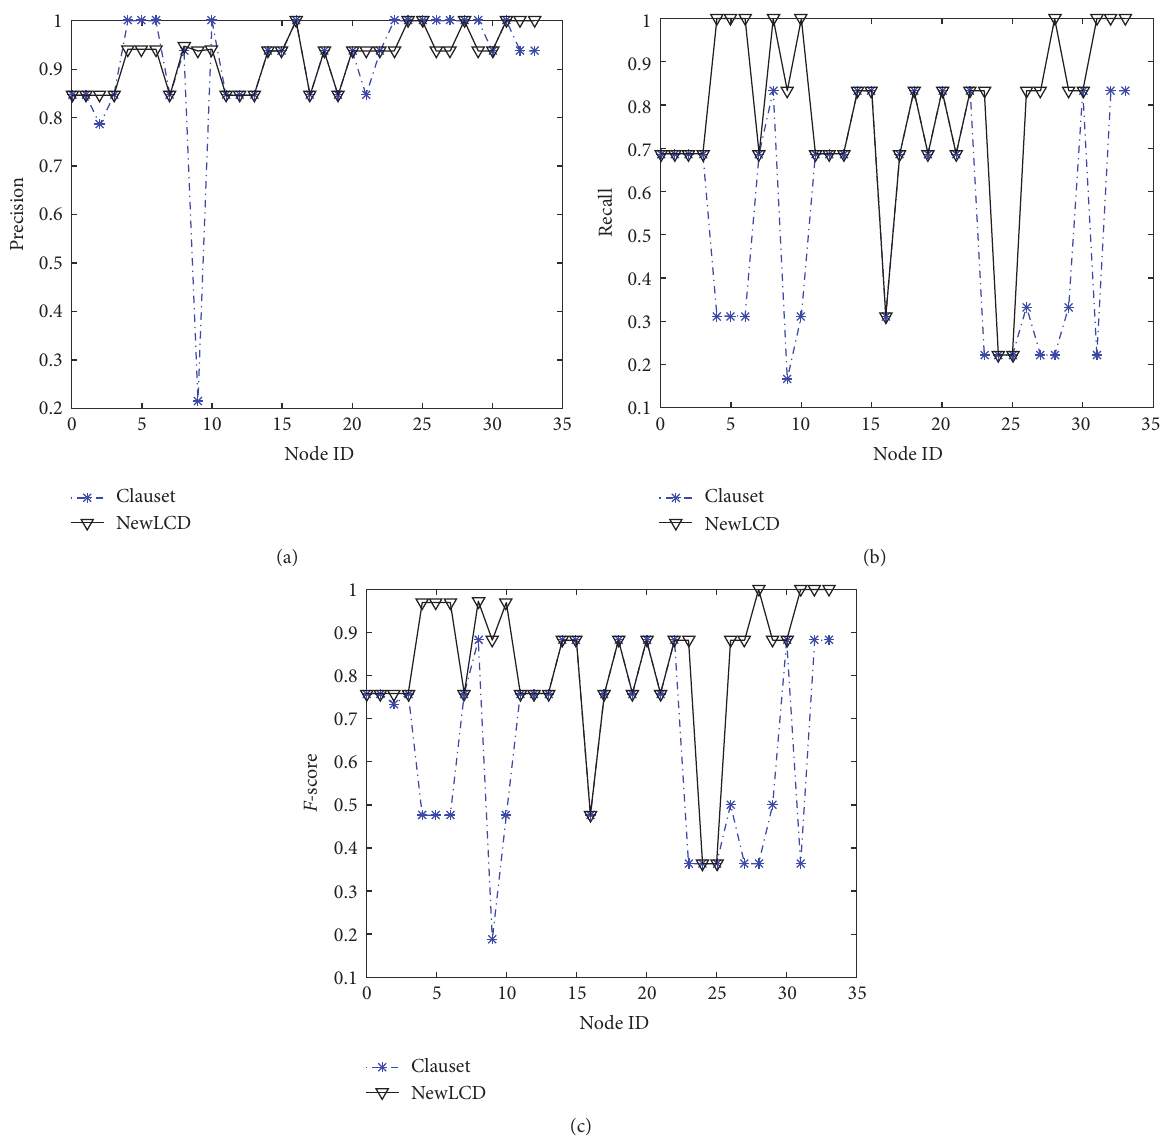
Figure 10: The contrast results of each node in